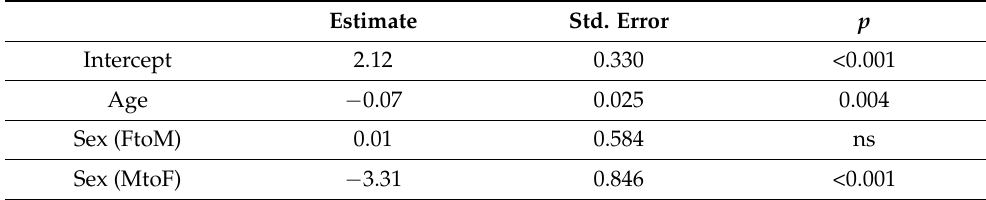
Figure 1. Number of intervals (out of 30) in which individuals were attentive to the iPad during Zoom session as a function of individual age and sex, with trendlines and 95% confidence intervals. ( Left ) panel shows males in Zoom sessions with female (dashed) or male (solid) partners. Young males were more attentive toward males than toward females, whereas older males were more attentive toward females than toward males. ( Right ) panel shows females in Zoom sessions with female (solid) or male (dashed) partners. Females were more attentive toward males than toward other females, and older females were less attentive overall than younger females. Table 1. Estimates from the Poisson regression for the number of intervals during which an individual was attentive to the iPad during the Zoom